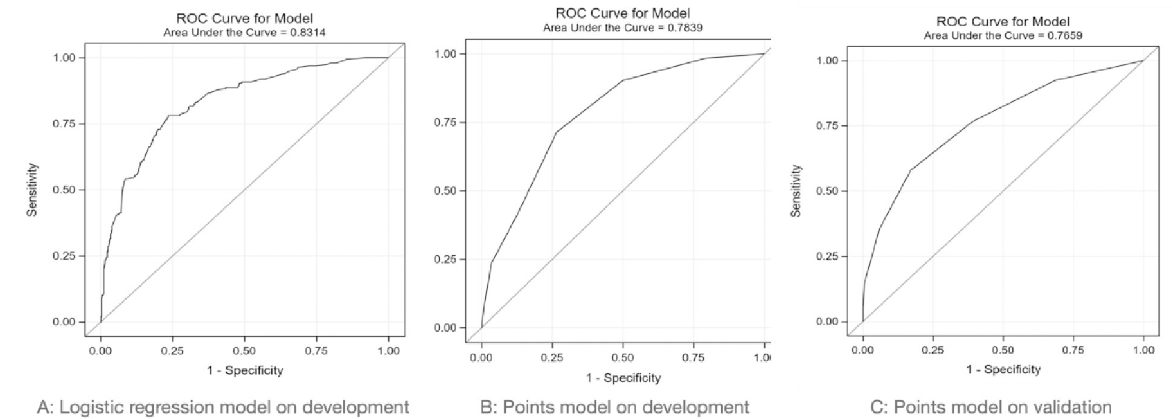
Fig 2. Area under receiver operating characteristic of: A) logistic regression model on the development database; B) PE-SCORE model on development database; and C) PE-SCORE model on validation database.